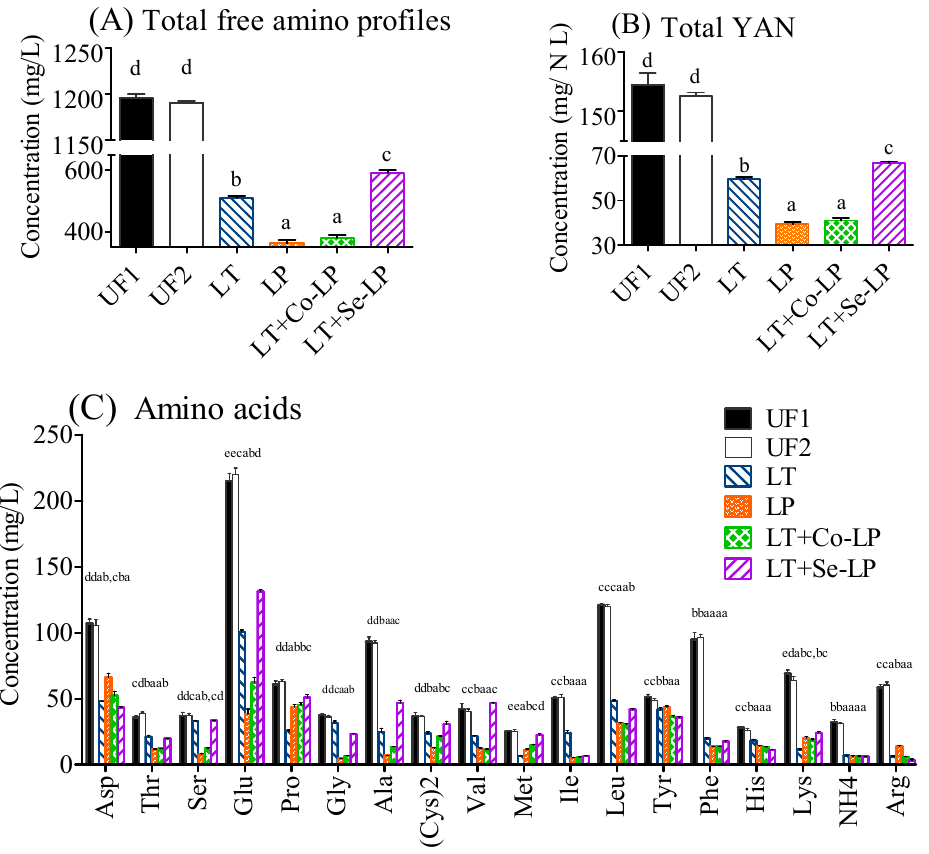
Figure 4. Total free amino profiles ( A ), total yeast assimilable nitrogen (YAN) ( B ), and specific amino compounds ( C ) in SCG hydrolysates at day 0 and day 14. UF1 and UF2: Unfermented SCG hydrolysates at D0 and D14; LT: L. thermotolerans Concerto; LP: L. plantarum ML Prime; LT+Co-LP: simultaneous inoculation of L. thermotolerans Concerto and L. plantarum ML Prime; LT+Se-LP: L. thermotolerans Concerto with sequentially inoculated L. plantarum ML Prime at day 4. a, b, c, d, e: Statistical analysis using ANOVA ( n = 3) at 95% confidence interval was conducted in the same row, different letter indicated significant